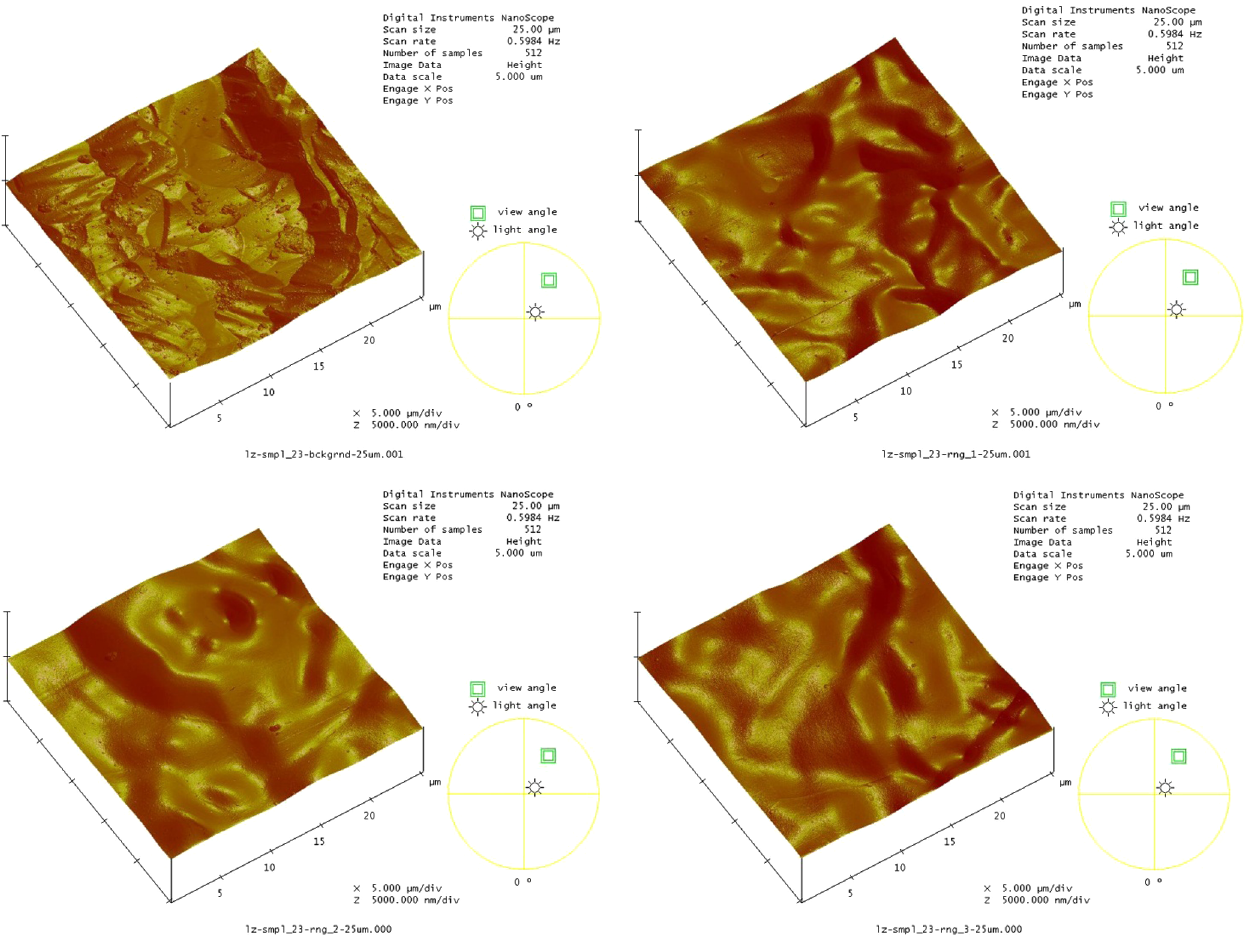
FIG. 7. AFM image of niobium surface after laser treatment with constant fluence ( 2 . 27 J = cm 2 ) and pulse accumulations. Top left, untreated BCP surface; top right, 11 pulses; lower left, 23 pulses; lower right, 34 pulses. Scan area: 25 μ m × 25 μ m. Horizontal scale: 5 μ m per division. Vertical scale: 0 . 5 μ m per division.